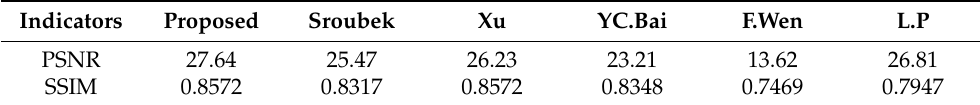
Figure 8. Sroubek’s sample restored experiment set 2 details. At the top, from left to right, are the results of Sroubek, Xu, and the proposed method; The next line, from left to right, shows the results of F.Wen, YC.Bai, and L.P. Table 5. Restoration quality evaluation table of Sroubek’s set2.